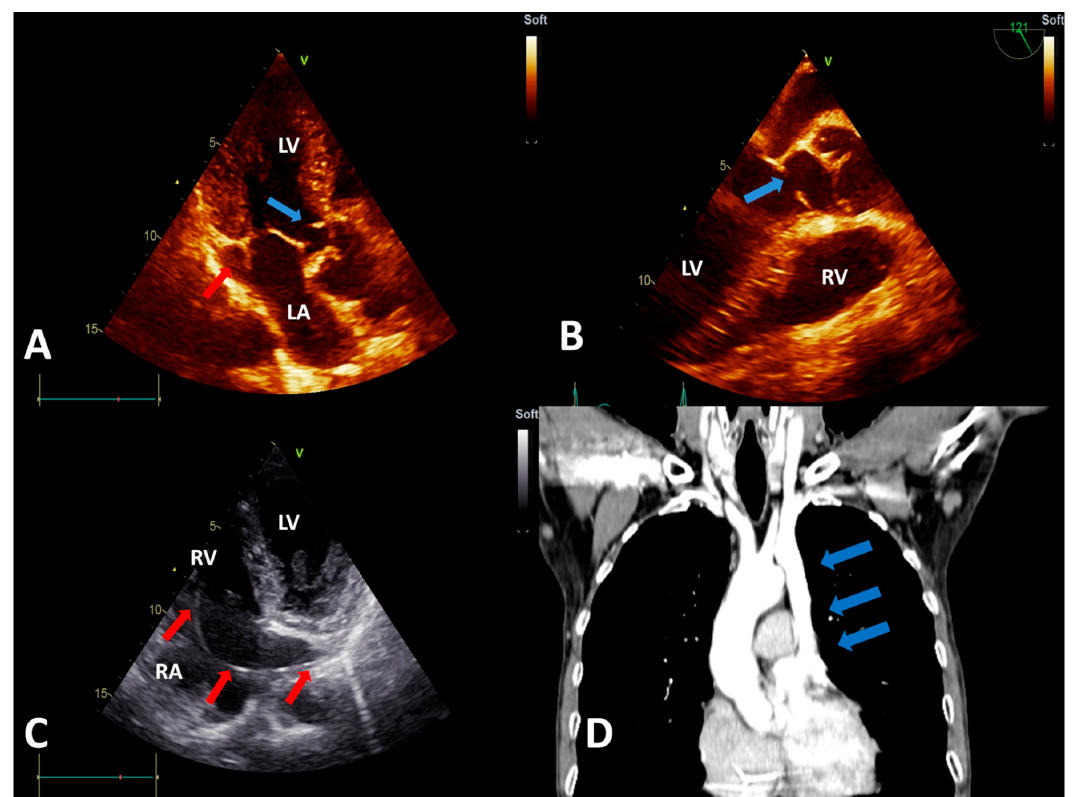
Figure 2. ( A ) Transthoracic echocardiography (TTE), apical 3-chamber view showing the subaortic membrane (blue arrow) and the dilated coronary sinus (red arrow). ( B ) Transesophageal echocardiography view showing the subaortic membrane (blue arrow). ( C ) TTE, modified apical 4-chamber view showing the pacemaker lead (red arrows) entering the right atrium via the dilated coronary sinus (visualized in longitudinal section). ( D ) Computed tomography angiography showing the persistent left superior vena cava (blue arrows), with an absent right superior vena cava. Abbreviations: LA, left atrium; LV, left ventricle; RA, right atrium; and RV, right ventricle.